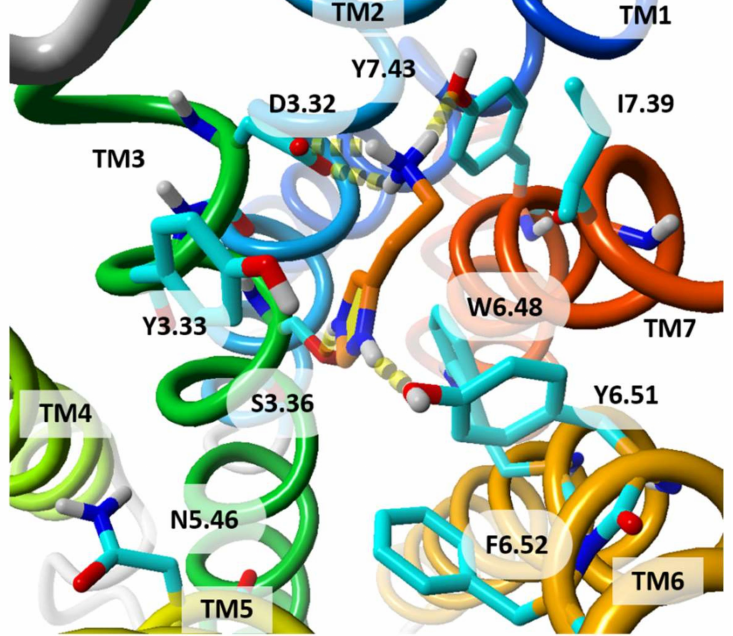
Figure 4. Histamine molecule docked to the crystal structure of hH 1 R. The histamine is doubly positively charged. The amine group is bound to D 3.32 and Y 7.43 , and the imidazole ring to S 3.36 and Y 6.51 . The residue numbers are shown in Ballesteros-Weinstein numbering scheme. Histamine is shown with its carbon atoms colored in orange. View from extracellular side. TM helices are colored from blue (TM1) to red